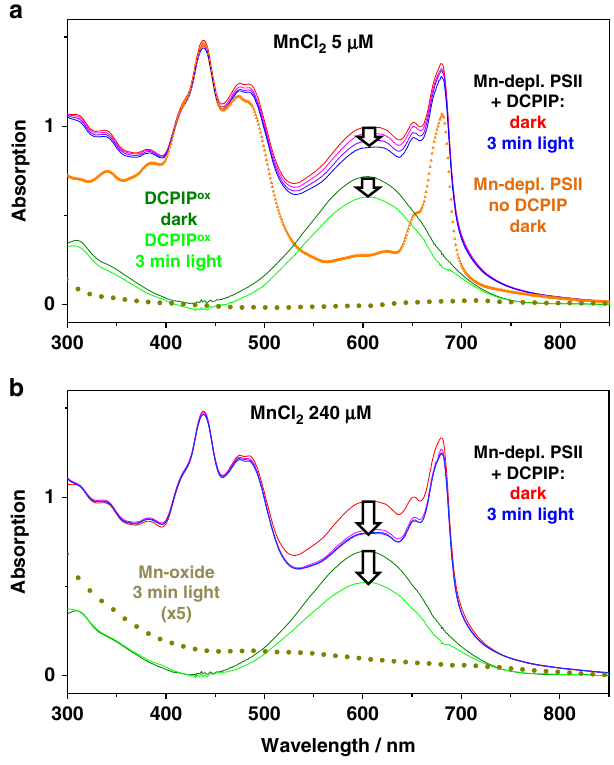
Fig. 3 Light-driven redox reactions in Mn-depleted PSII tracked by optical spectroscopy. a , b UV – vis absorption spectra. The orange line (triangles) represents a suspension of Mn-depleted PSII before the addition of DCPIP (60 µ M) serving as arti fi cial electron acceptor (buffer conditions: 1 M glycine-betaine, 15 mM NaCl, 5 mM CaCl 2 , 5 mM MgCl 2 , 25 mM MES buffer, pH 7; for further details see SI). Then DCPIP ox and either 5 µ M MnCl 2 (in a ) or 240 µ M MnCl 2 (in b ) were added, followed by continuous white-light illumination (1000 µ E m − 2 s − 1 ) of the PSII suspensions and collection of spectra (one spectrum per minute; immediately prior to illumination, red lines, and after 3 min light, blue lines). The green and light- green lines correspond to the spectral contributions of DCPIP ox to the dark and 3-min light spectra; the amplitude decrease at 604 nm represents the loss of DCPIP ox due to its reduction by PSII (arrows). The dark-yellow dotted spectra are assignable to a Mn oxide, as veri fi ed by X-ray absorption spectroscopy (spectra obtained by weighted spectral deconvolution, see caption of Supplementary Fig. 6, and scaled by a factor of 5, for clarity). Note that signi fi cant spectral changes due to Mn-oxide formation were only observed with 240 µ M MnCl 2 (in b ), but not with 5 µ M MnCl 2 (in a ). Source data are provided as a Source Data fi